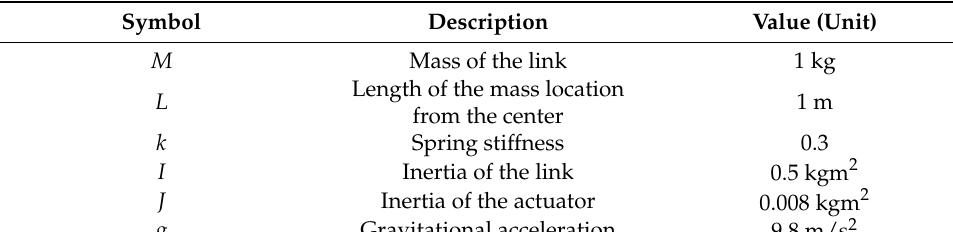
Figure 2. Block diagram of the SFJRM with proposed output feedback controller.